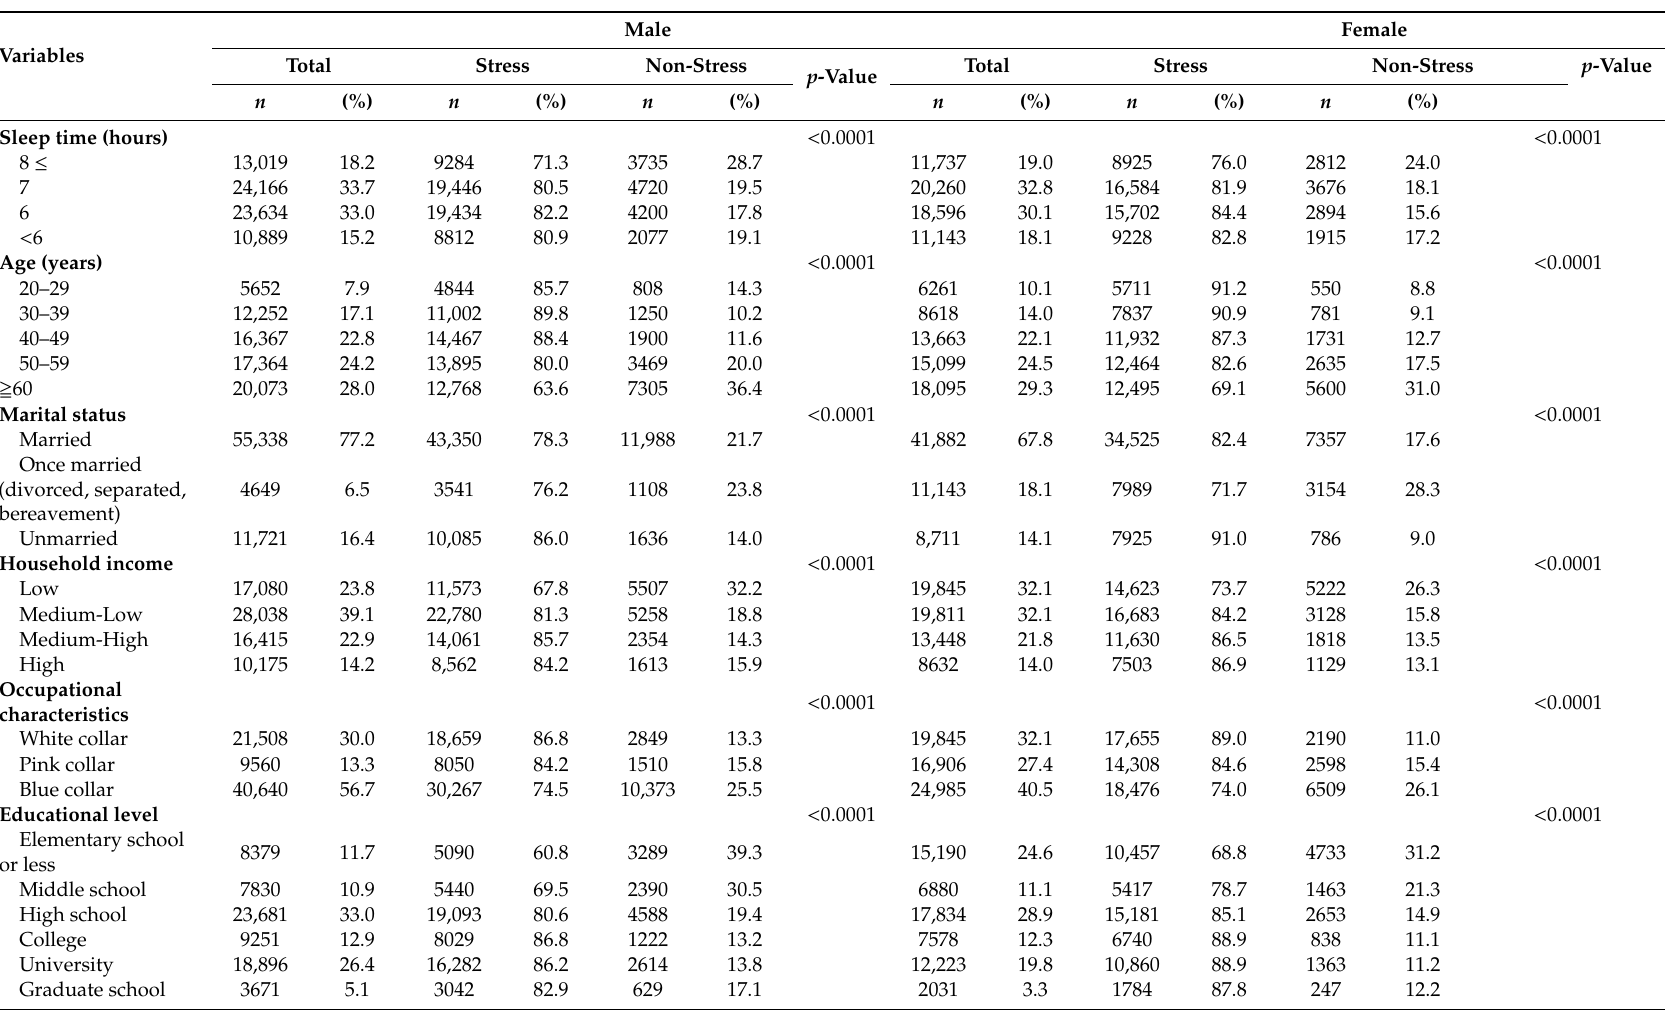
Table 1. General characteristics of study observations